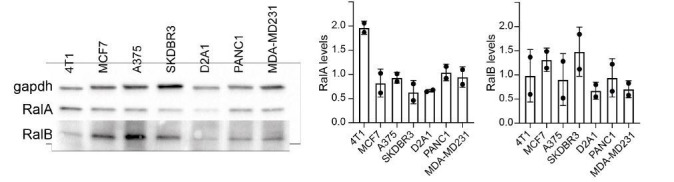
RAL expression.RalA and RalB expression assessed by western blots (Left in multiple cell types and quantified (Right). Each dot represents one experiment.